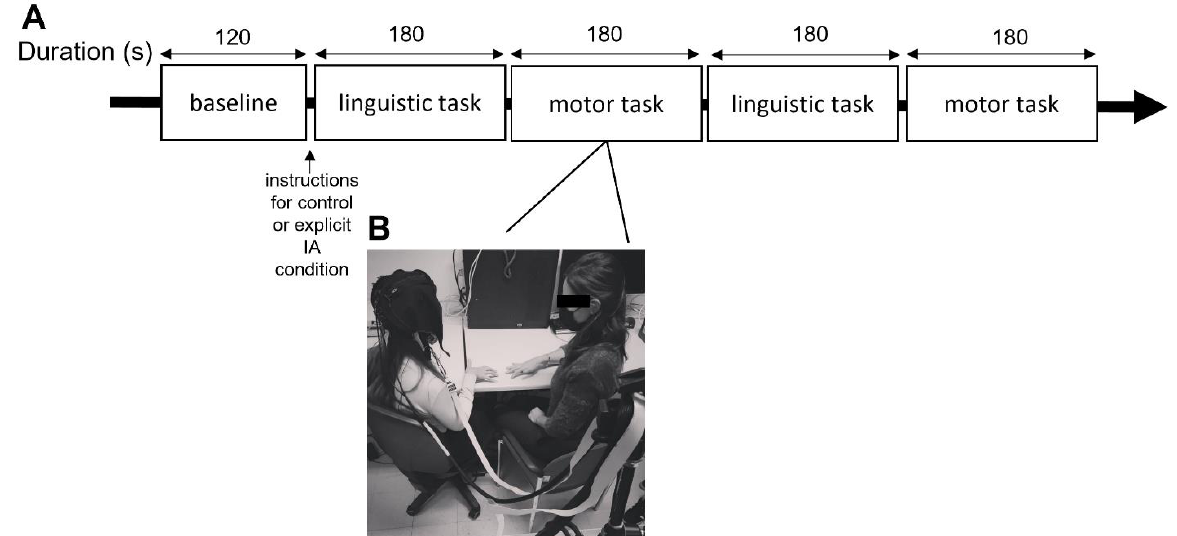
Figure 1. Experiment setup. ( A ) The experimental procedure with the synchronization tasks duration and timing of the instructions provided for the explicit IA and control conditions. ( B ) Example of the experimental setting with fNIRS device recording and the experimenter during the task execution (i.e., for the motor task).